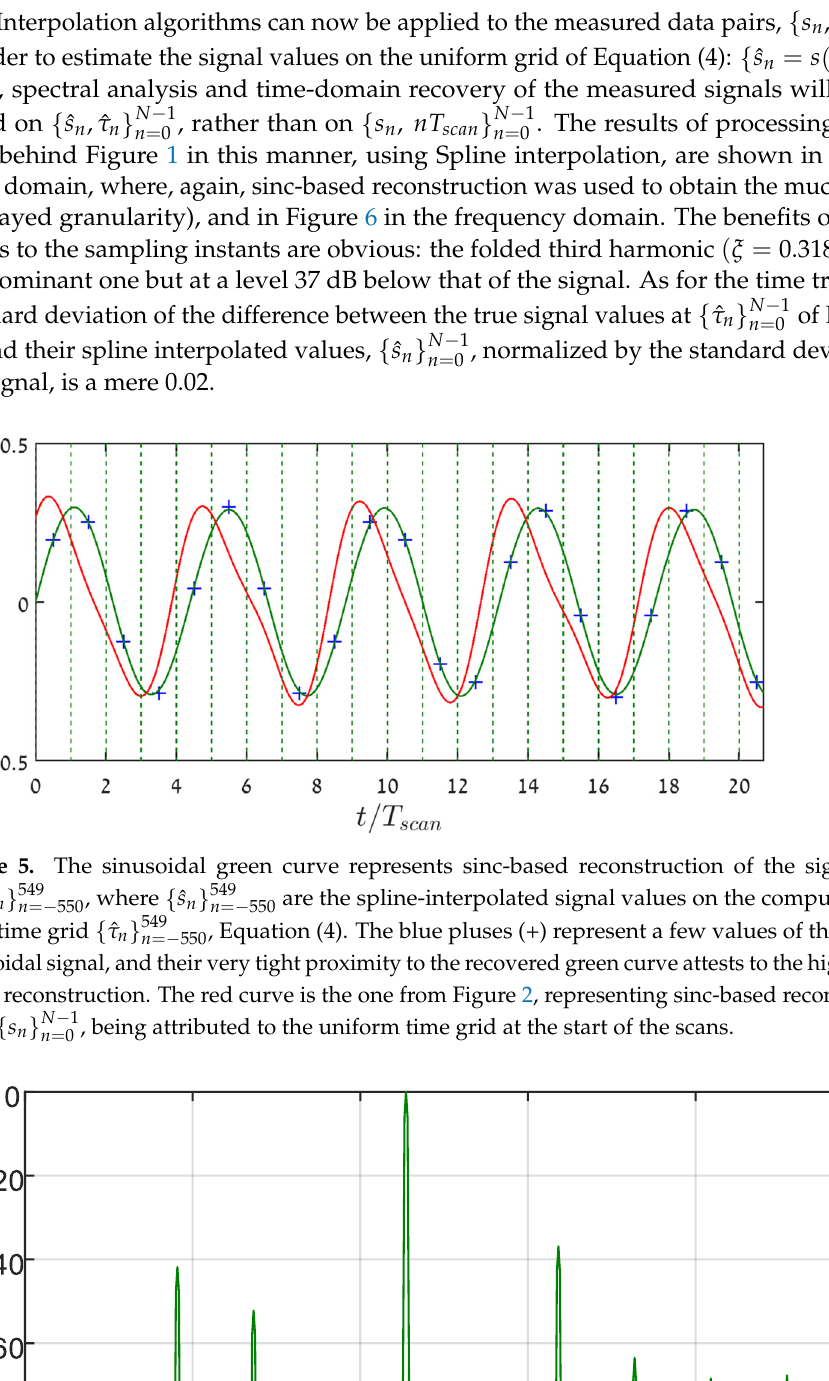
, where n = − 550 , Equa- n = − 550 . n = − 550